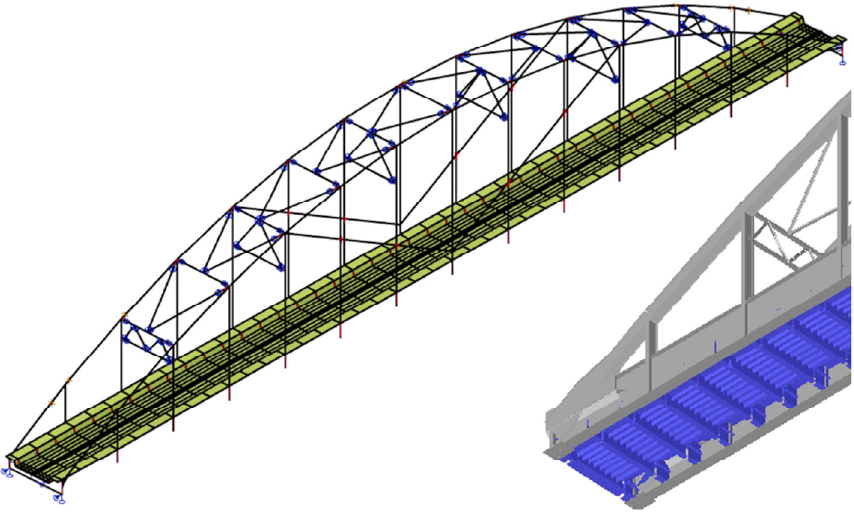
Figure 6. Finite element method (FEM) model in SCIA Engineering with most parts as beam finite elements.